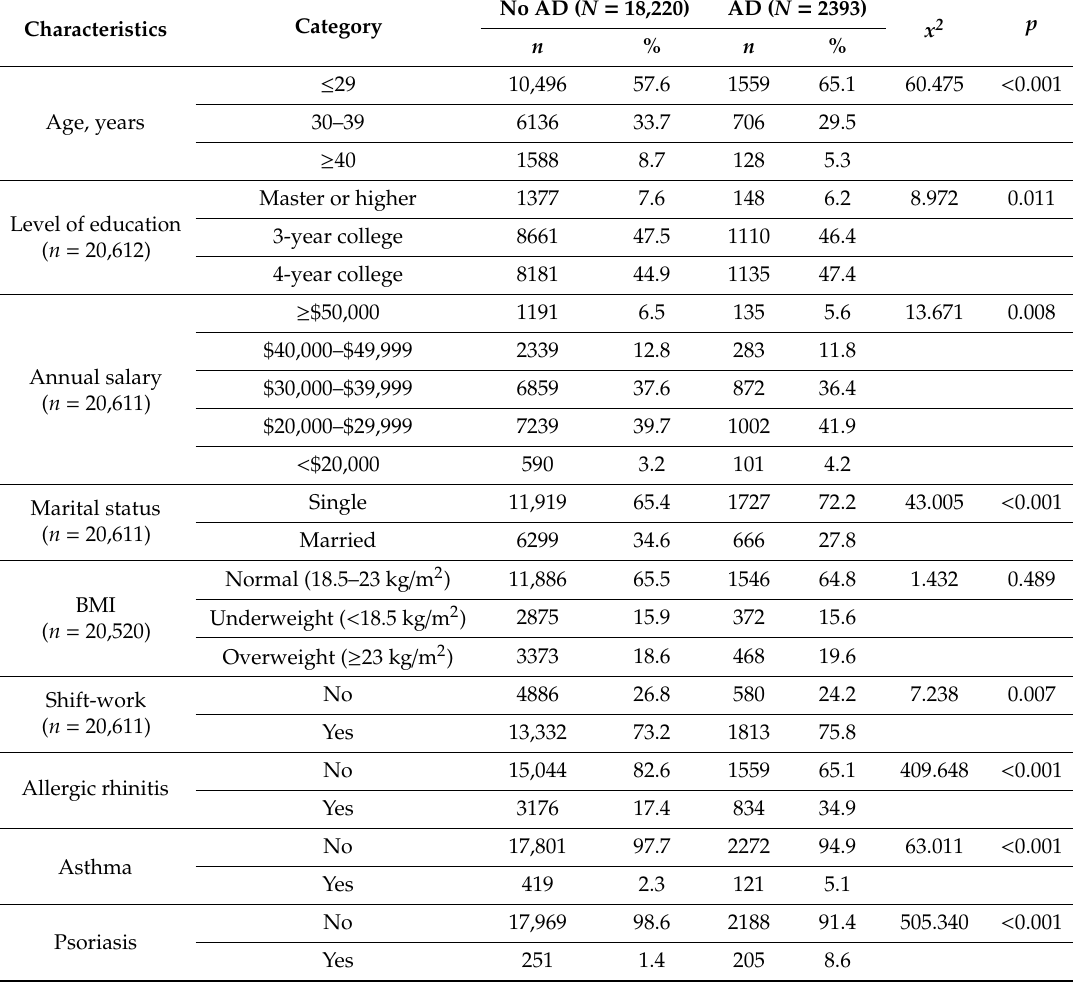
Table 1. Baseline characteristics according to atopic dermatitis ( N = 20,613).